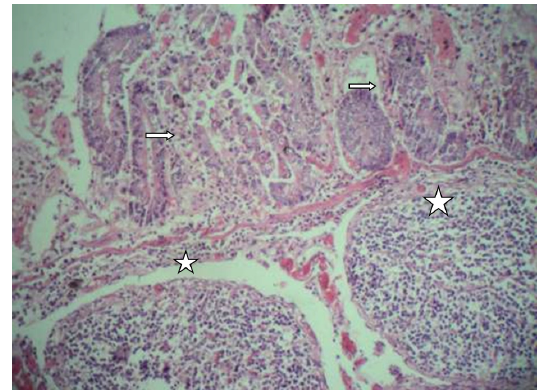
Fig. 9. Spleen: showing severe lymphoid depletion of the germinal centers. H&E × 100(Ezeasor, 2012)